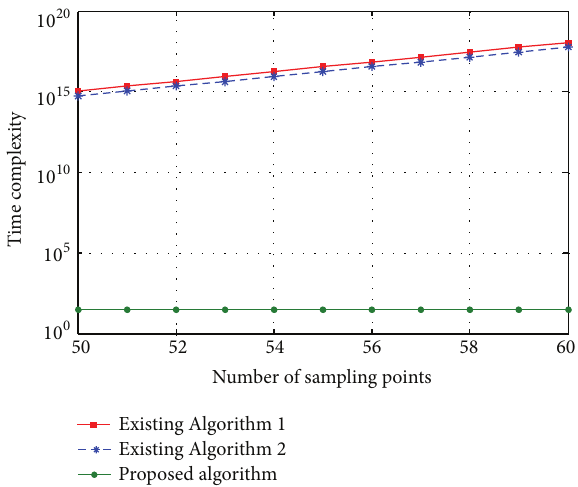
Figure 4: Comparison among proposed algorithm, existing Algo- rithm 1, and existing Algorithm 2 in terms of time complexity considering 𝑚 = 1 and 𝑘 = 2 .